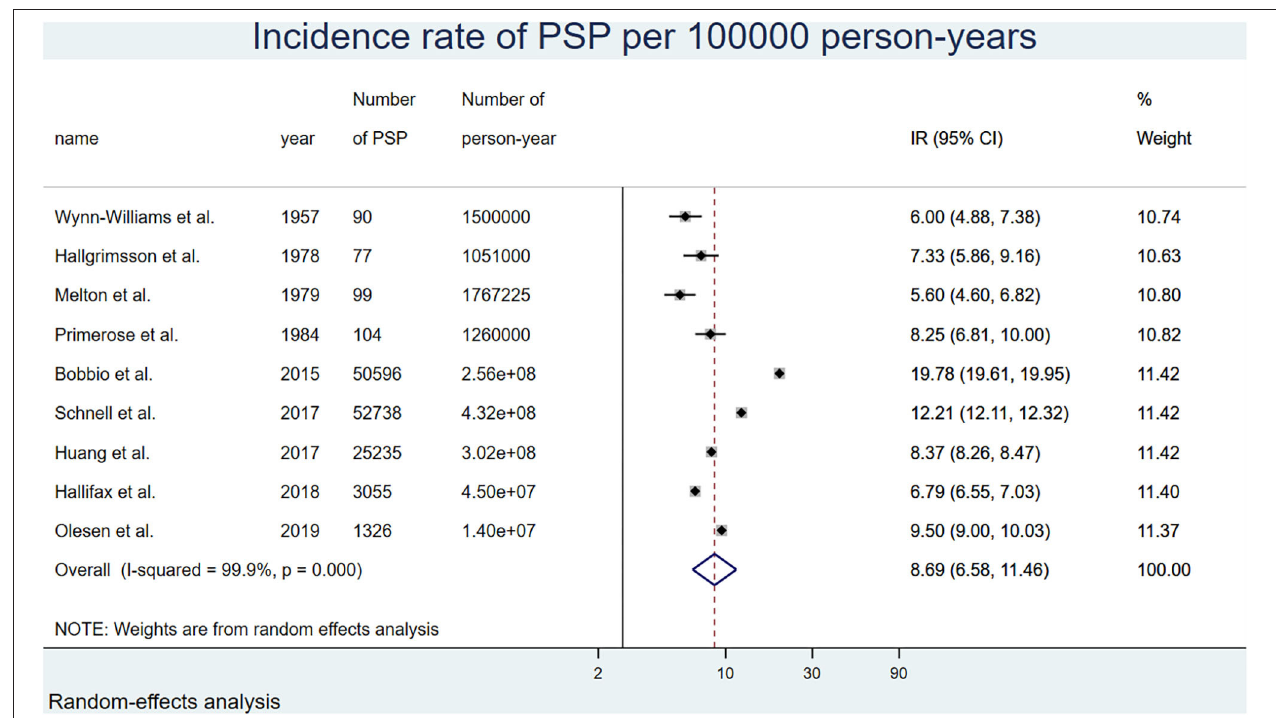
FIGURE 2 | Forest plot of the overall incidence rate of pneumothorax for 100,000 person-years corrected for relapses, random-effects model.